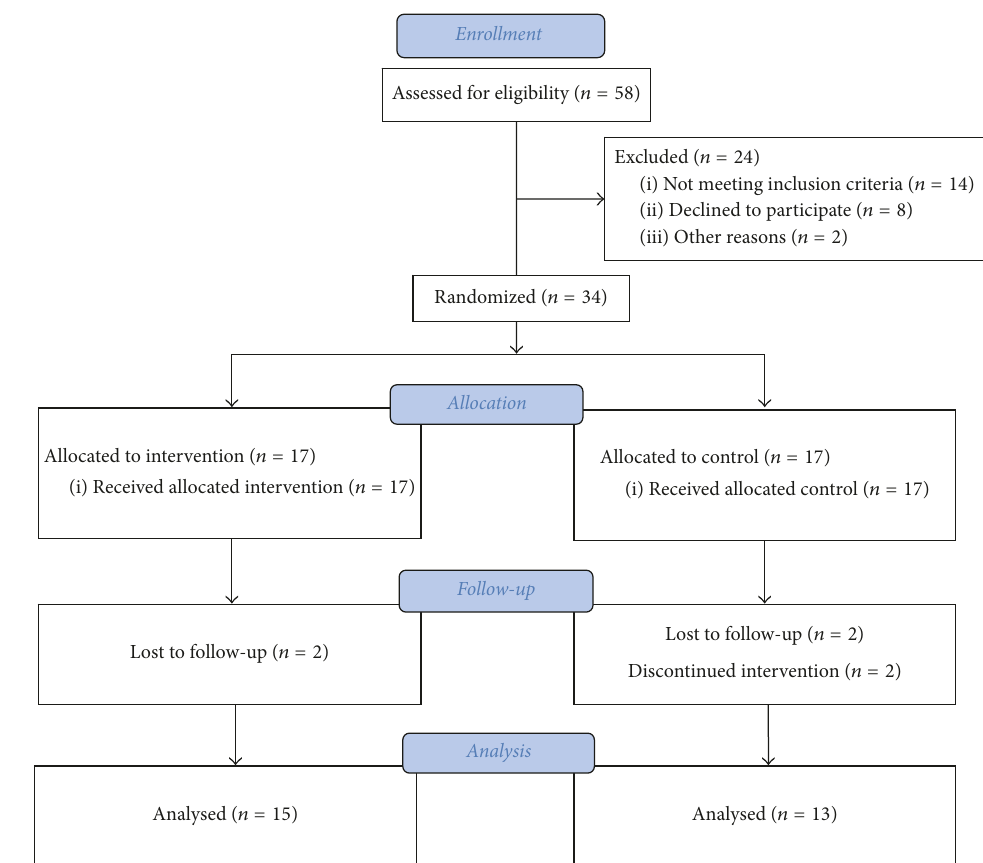
Figure 1: Flowchart of the